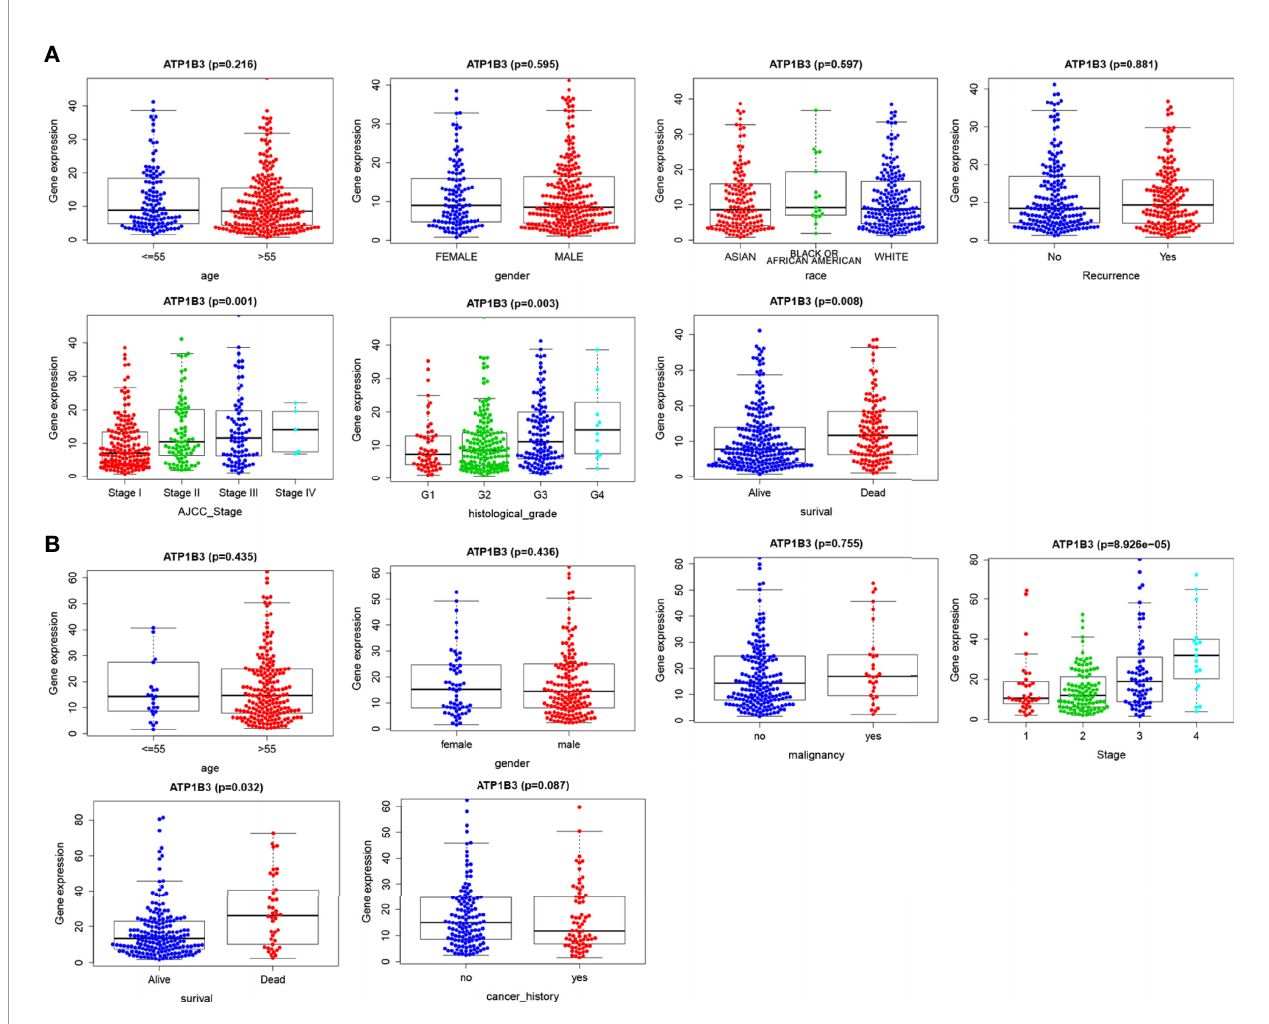
FIGURE 3 | ATP1B3 is correlated with clinicopathological characteristics of HCC patients. (A) TCGA database. (B) ICGC